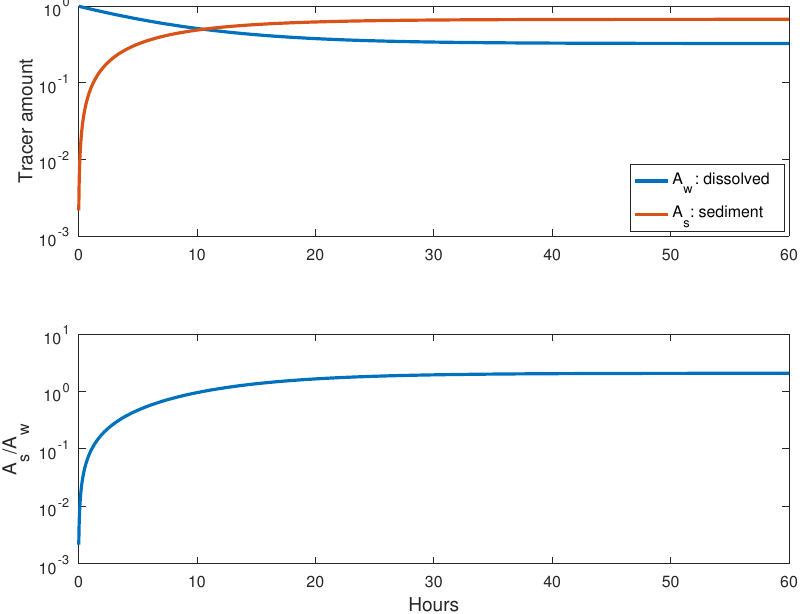
Figure 2. Fractions of tracers in dissolved and sediment form ( top ) and the ratio between them ( bottom ). Clearly, at the early stages after an accidental tracer release into the sea, a k d model cannot be applied since it will overestimate the concentration in the sediment and underes- timate the concentration in